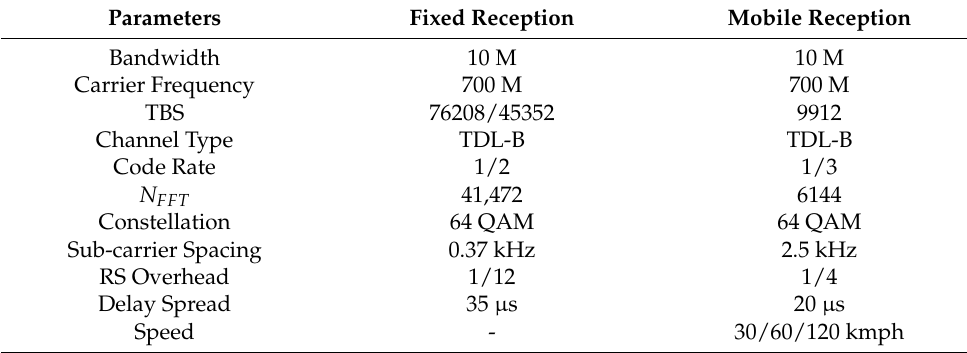
Table 1. Simulation